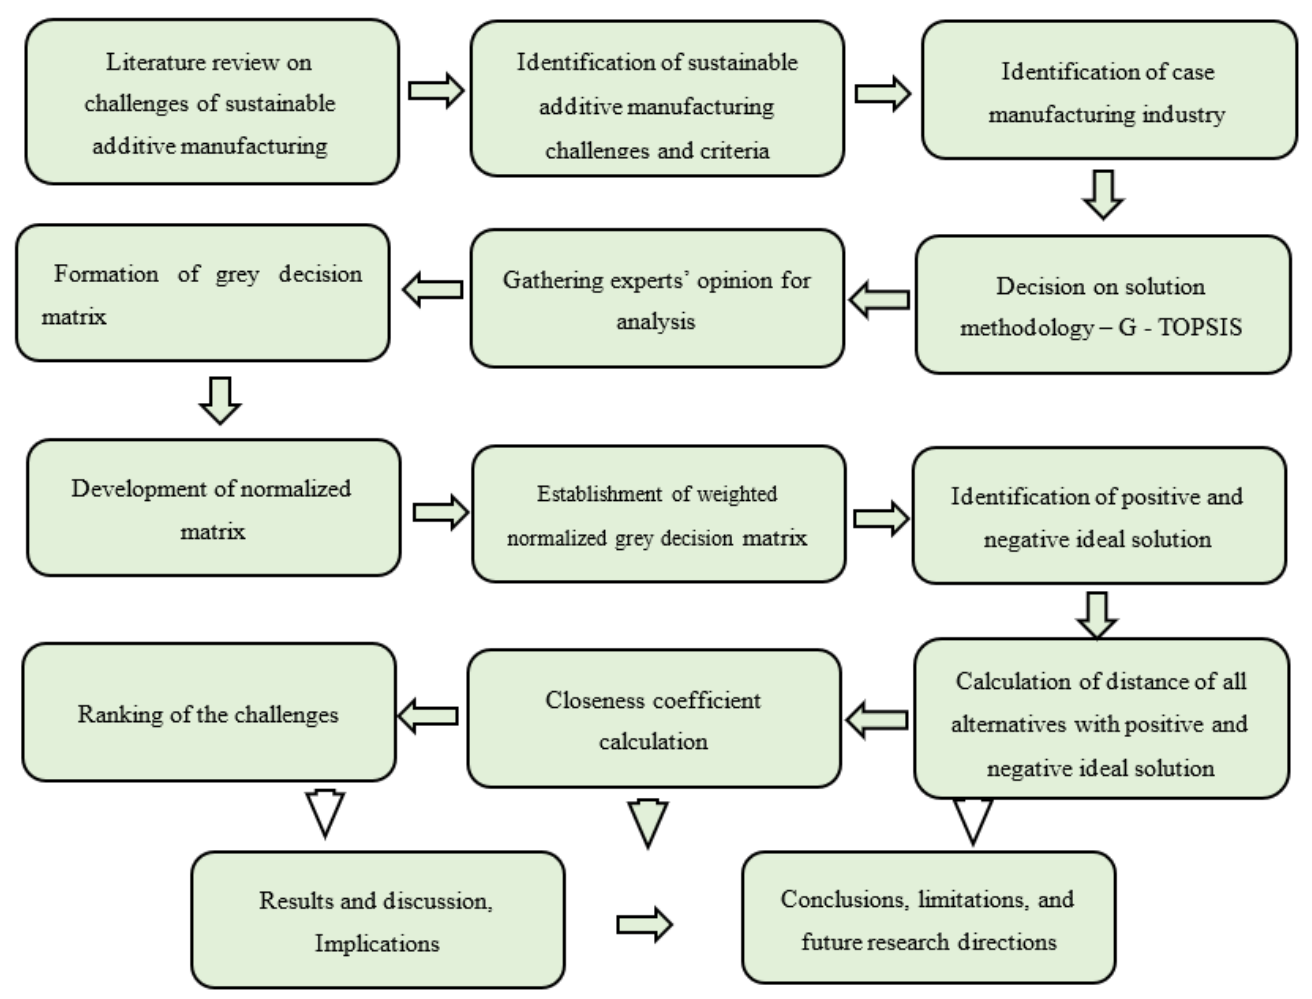
Figure 1. Research methodology.